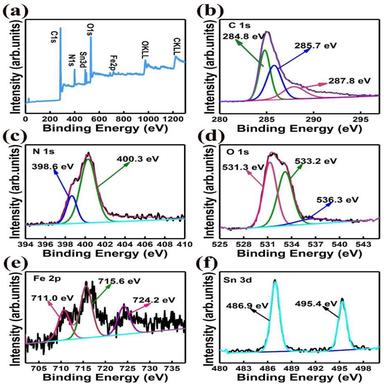
XPS spectra of SnO2@FeOOH@C nanospheres: (a) survey, (b) C 1s, (c) N 1s, (b) O 1s, (e) Fe 2p, and (f) Sn 3d.